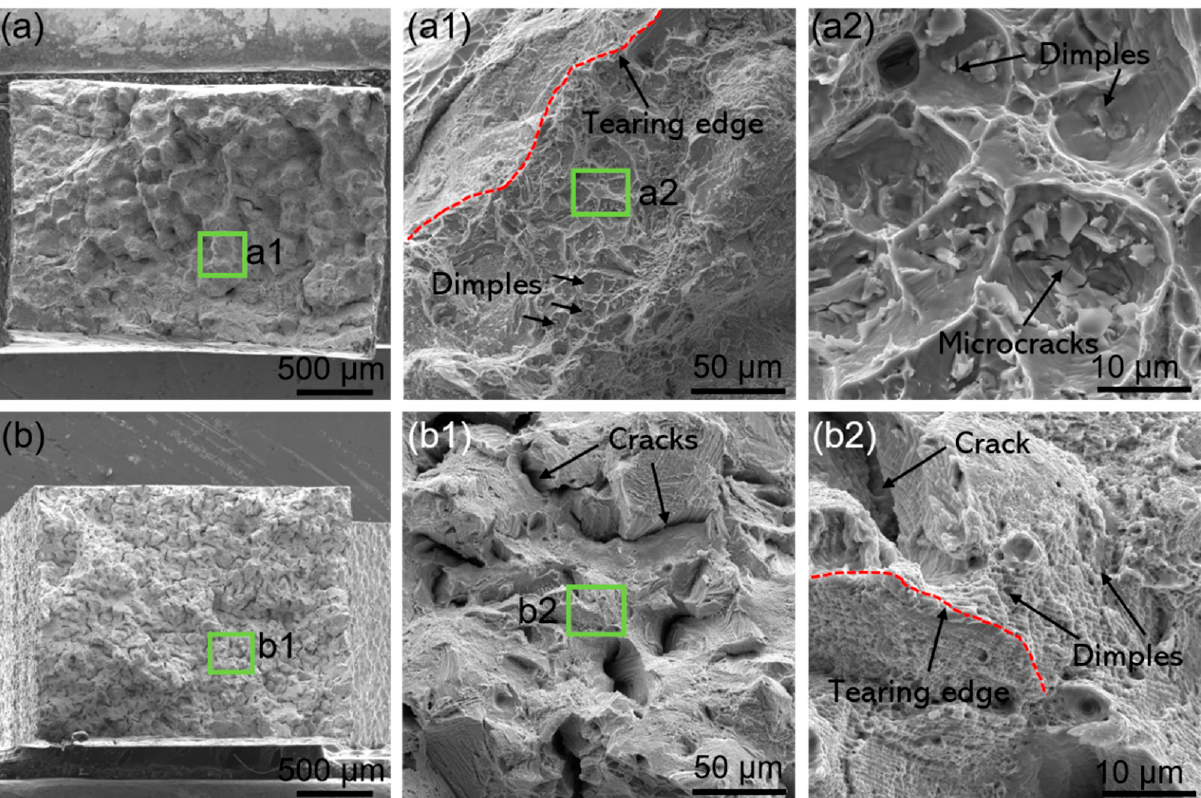
Figure 6. SEM images of tensile fracture surface for K213 alloy. ( a ) As-casting, ( a1 ) Local magnified area of the green box in ( a ), ( a2 ) Local magnified area of the green box in ( a1 ). ( b ) SLM, ( b1 ) Local magnified area of the green box in ( b ), ( b2 ) Local magnified area of the green box in ( b1 ). During the tensile deformation of the as-cast K213 alloy, there is a deformation in- compatibility between the MC precipitates and the alloy matrix. Therefore, microvoids are formed between the second-phase particles and the matrix. With the further increase in deformation, the microvoids grow up, aggregate, and penetrate until the alloy fractures, thus forming dimples at the fracture surface. The results show that the MC caused by element segregation in the as-cast alloy is the main reason for the decrease in strength. On the other hand, the SLM K213 alloy without precipitates exhibits higher strength during tension; the inherent cracks are the main reason for limiting its further increase in strength and reduction of